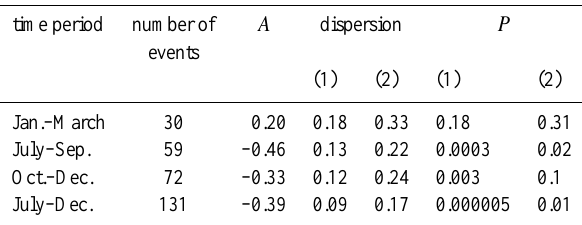
Table 2. Statistical significance of east-west asymmetry observed in